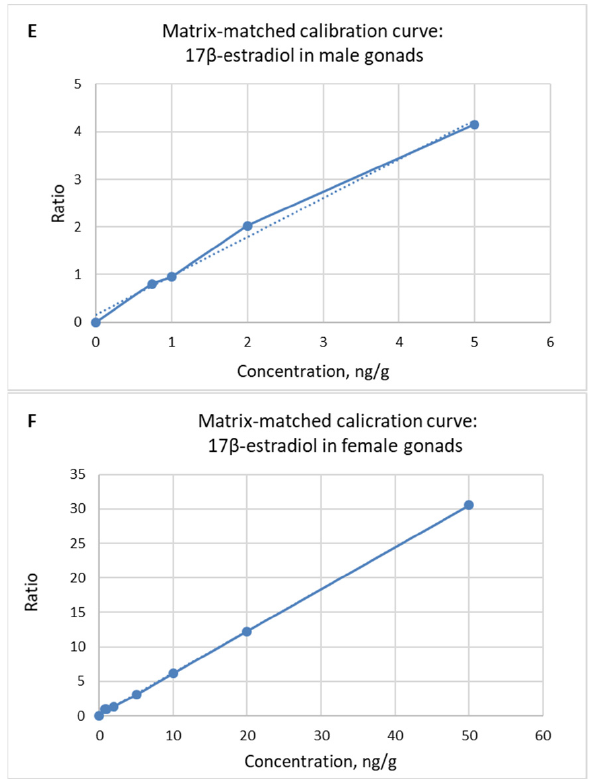
Figure 6. Linearity of the method evaluated in male and female gonad matrix-matched calibration: ( A , B )—17 β -T, ( C , D )—11-KT, ( E , F )—17 β -E2.